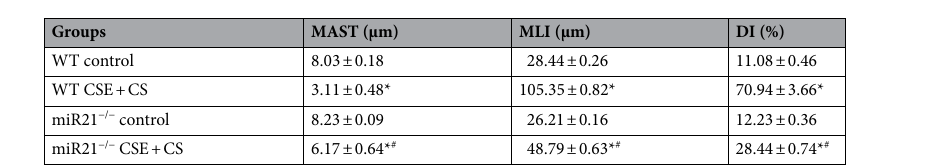
Figure 2. MiR-21 knockout alleviate COPD-related emphysema, lung functions and pulmonary inflammation changes. ( A )–( D ) H&E staining on paraffin-embedded mice lung tissue sections from control group, WT-COPD group, miR-21 −/− COPD group and miR-21 −/− control group respectively. The WT-COPD group exhibited enlarged alveolar space, thinner alveolar septum, and destroyed alveolar wall when compared with the control. Meanwhile, the miR-21 −/− COPD group had moderate pathological changes compared with the WT COPD group, but still worse than the control and the miR-21 −/− group have no notable changes when exposed to air. ( E ) The inflammation score of mice lung from different groups. The WT-COPD group had the highest inflammation score, followed by miR-21 −/− COPD group, and the miR-21 −/− control group was similar to WT control group. Magnification are all 400X, scale bar = 50 nm, The data are expressed as the mean ± SEM (n = 5 in each group). *: compared with the control group, P < 0.05; # : compared with the WT COPD group, t-test and ANOVA test were applied in this part, P < 0.05.